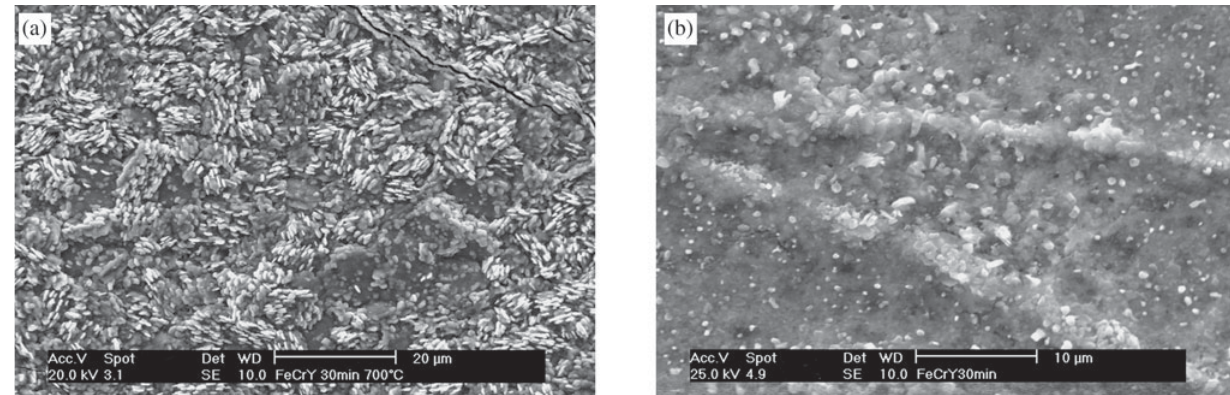
Figure 10. Surface of the FeCrY alloy sulfidized for 30 min at 700 °C.